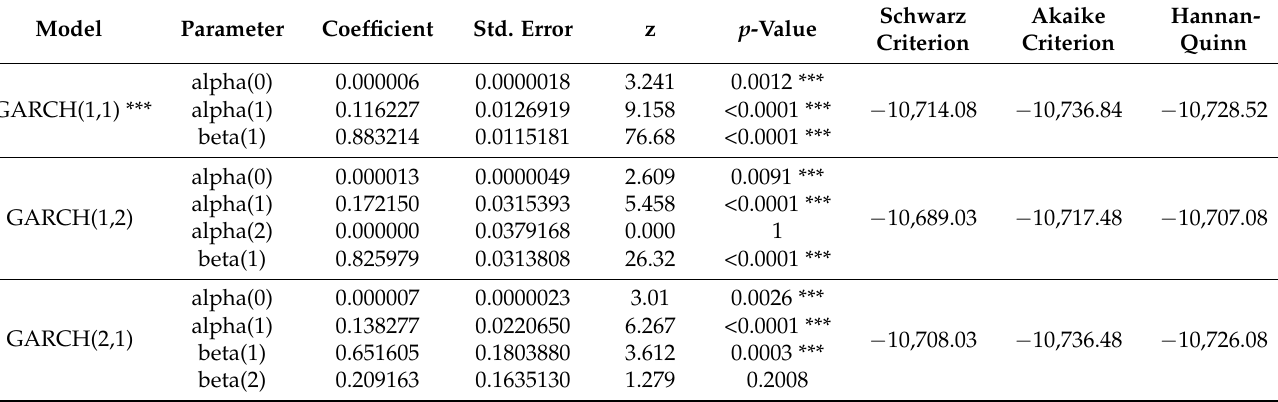
Table A4. Parameters and statistics the GARCH models in case of crude